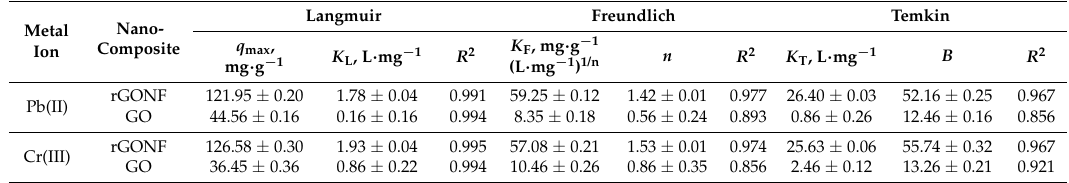
Table 3. Isotherm parameters of Pb(II) and Cr(III) ( C o = 2.0 to 25 mg · L − 1 ) adsorption onto rGONF